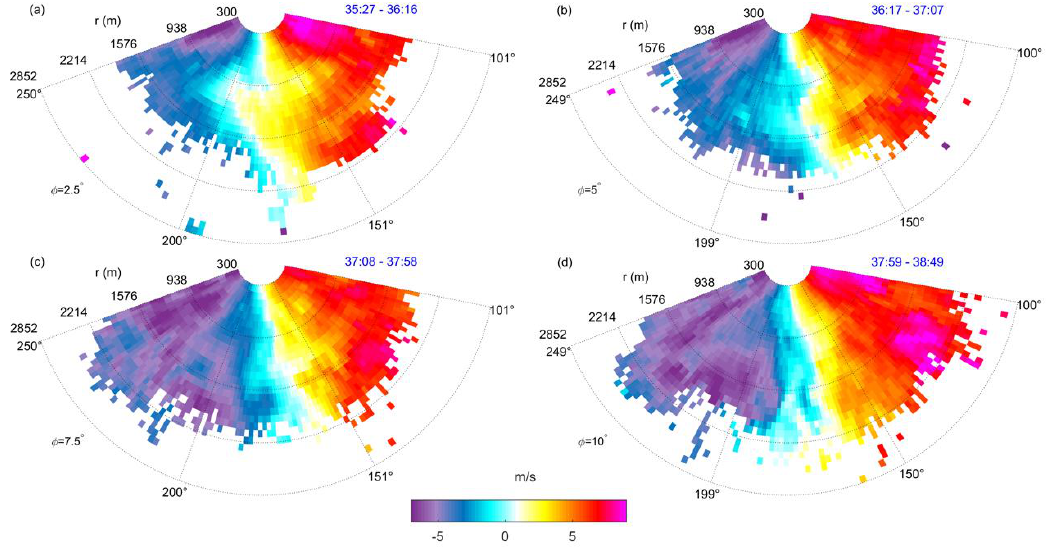
Figure 16. Doppler velocity measured during the time of bridge collapse by the WSL400s lidar located in the Port of Genoa. The beam elevation ( 𝜑 ) and the scanning time interval in MM:SS (blue text; the hour in all plots is 09:00 UTC) provided in each figure ( a )–( d ).